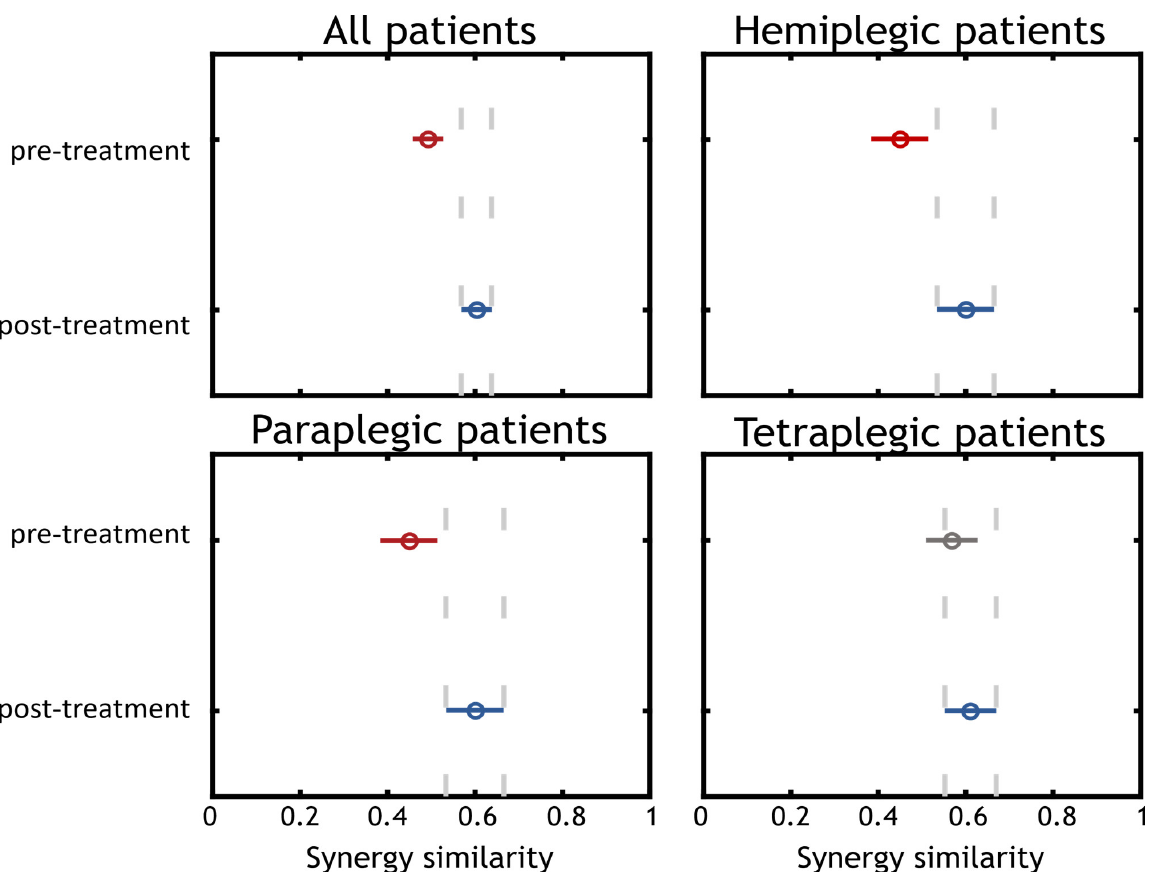
Figure 7. Statistical analysis. Statistical analysis was performed on each group of patients separately and for all subjects in the same group. We found that for the “All patients”, “Hemiplegic Patients”, “Paraplegic Patients” results were statistically significant (Post treatment synergy similarity in respect to controls increased), while for the “Tetraplegic Patients” group, there was a slight median increase of the MSS which was not statistically significant.